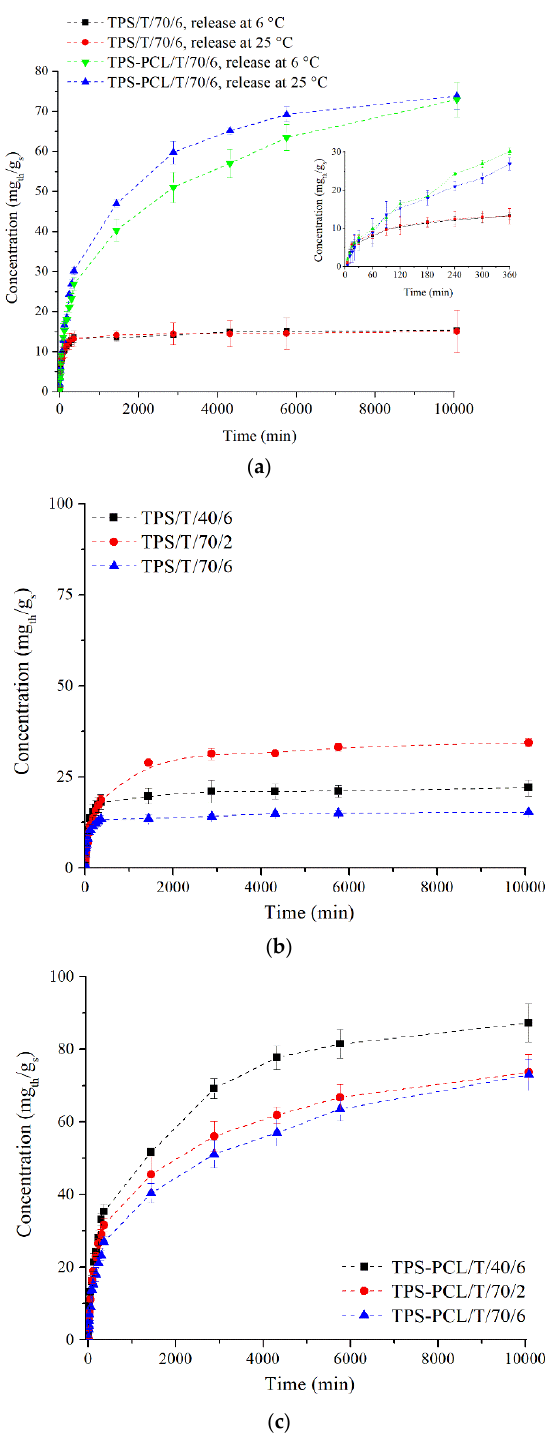
Figure 6. ( a ) Thymol release at 25 °C and 6 °C from TPS/T/70/6 and TPS–PCL/T/70/6 (inserted graph shows the release profile during the first 6 h), ( b ) cumulative release of thymol at 6 °C from TPS samples, and ( c ) cumulative release of thymol at 6 °C from TPS–PCL samples.